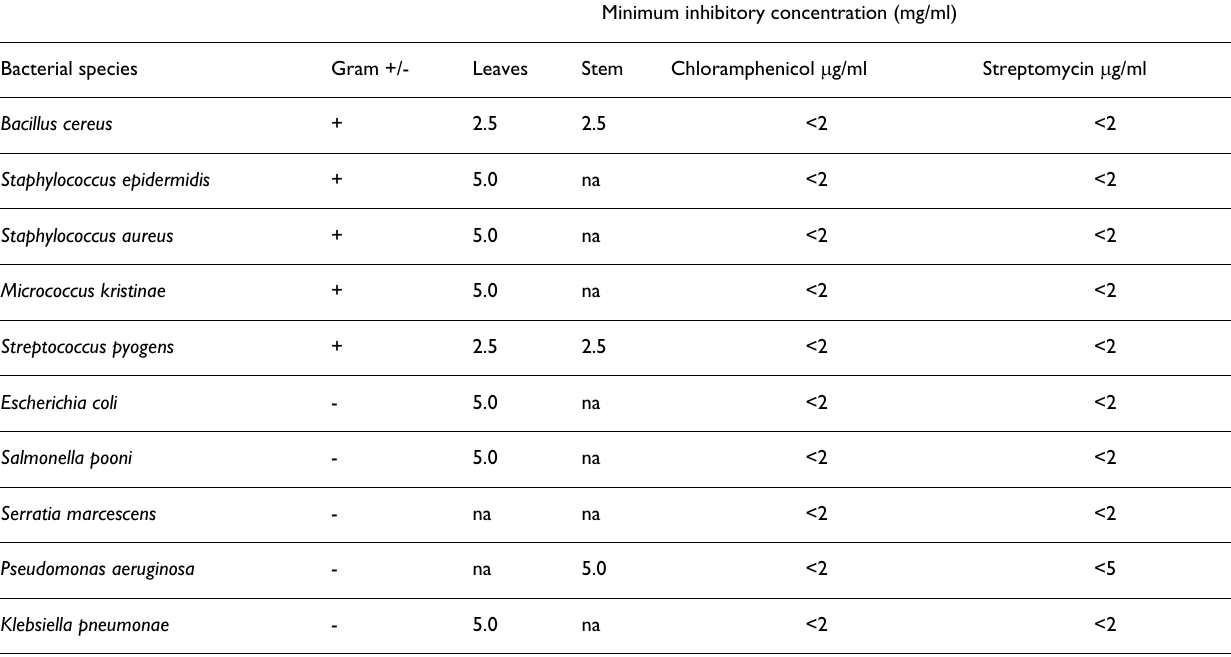
Minimum inhibitory concentration (mg/ml)